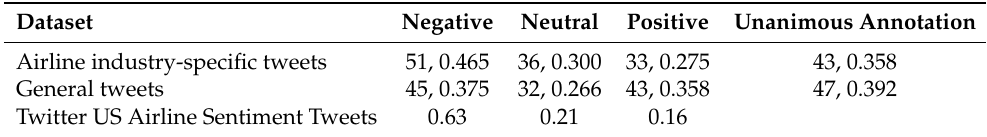
Table 3. Labeling statistics regarding how humans manually assessed the polarity (number of tweets and